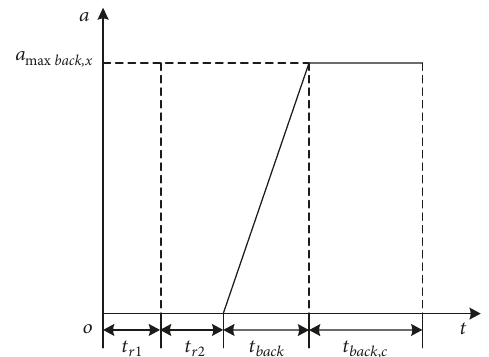
Figure 13: Braking deceleration changes of rear